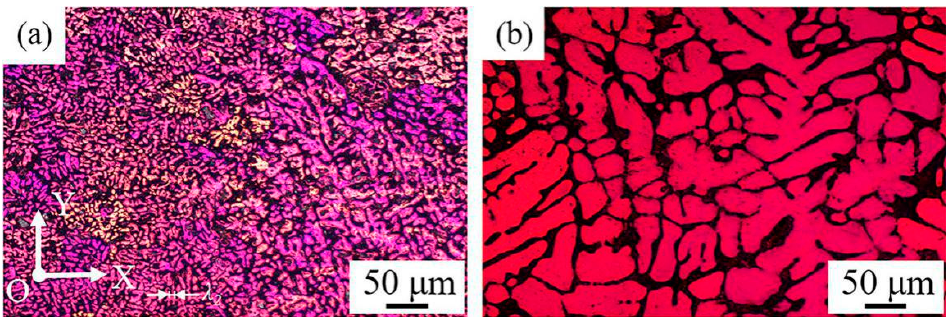
Figure 3. ( a ) Grain structure in face XOY of the as-deposited samples; ( b ) Grain structure of casting AlSi7Mg0.6 alloy.